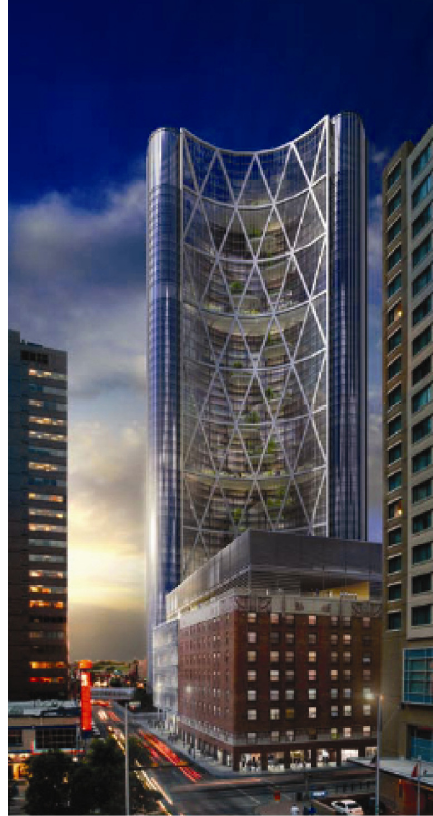
Fig. 2. The “Bow” Diagrid Tower (courtesy of Foster +